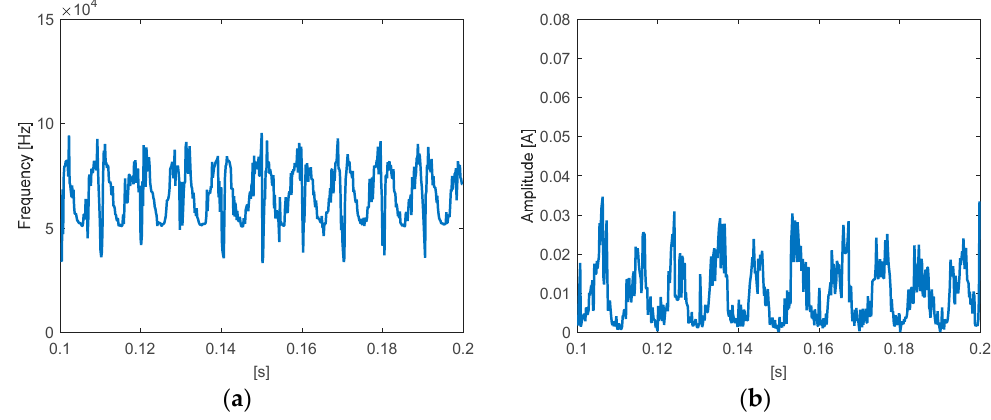
Figure 10. Case study 3: ( a ) Frequency and ( b ) amplitude of a time varying high-frequency component obtained by SWWMEM.